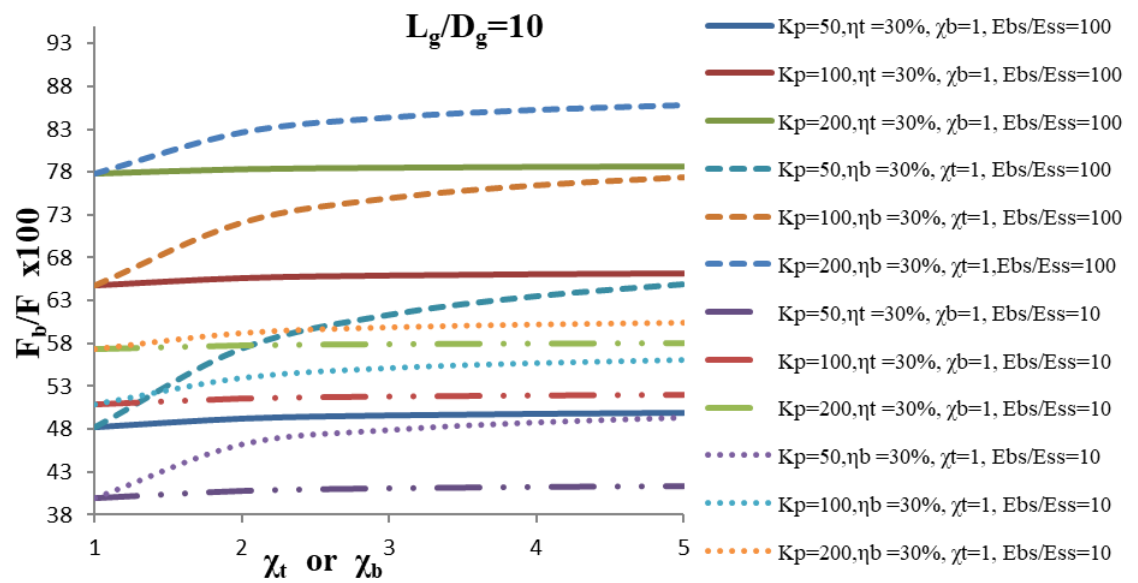
/F)x100 with strengthening factor for the top, χ b , and relative stiffness of bearing stratum, E p